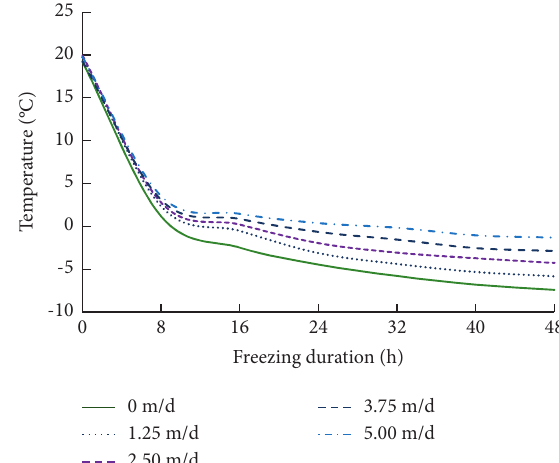
Figure 7: Time history of the temperature at survey points T1–6.